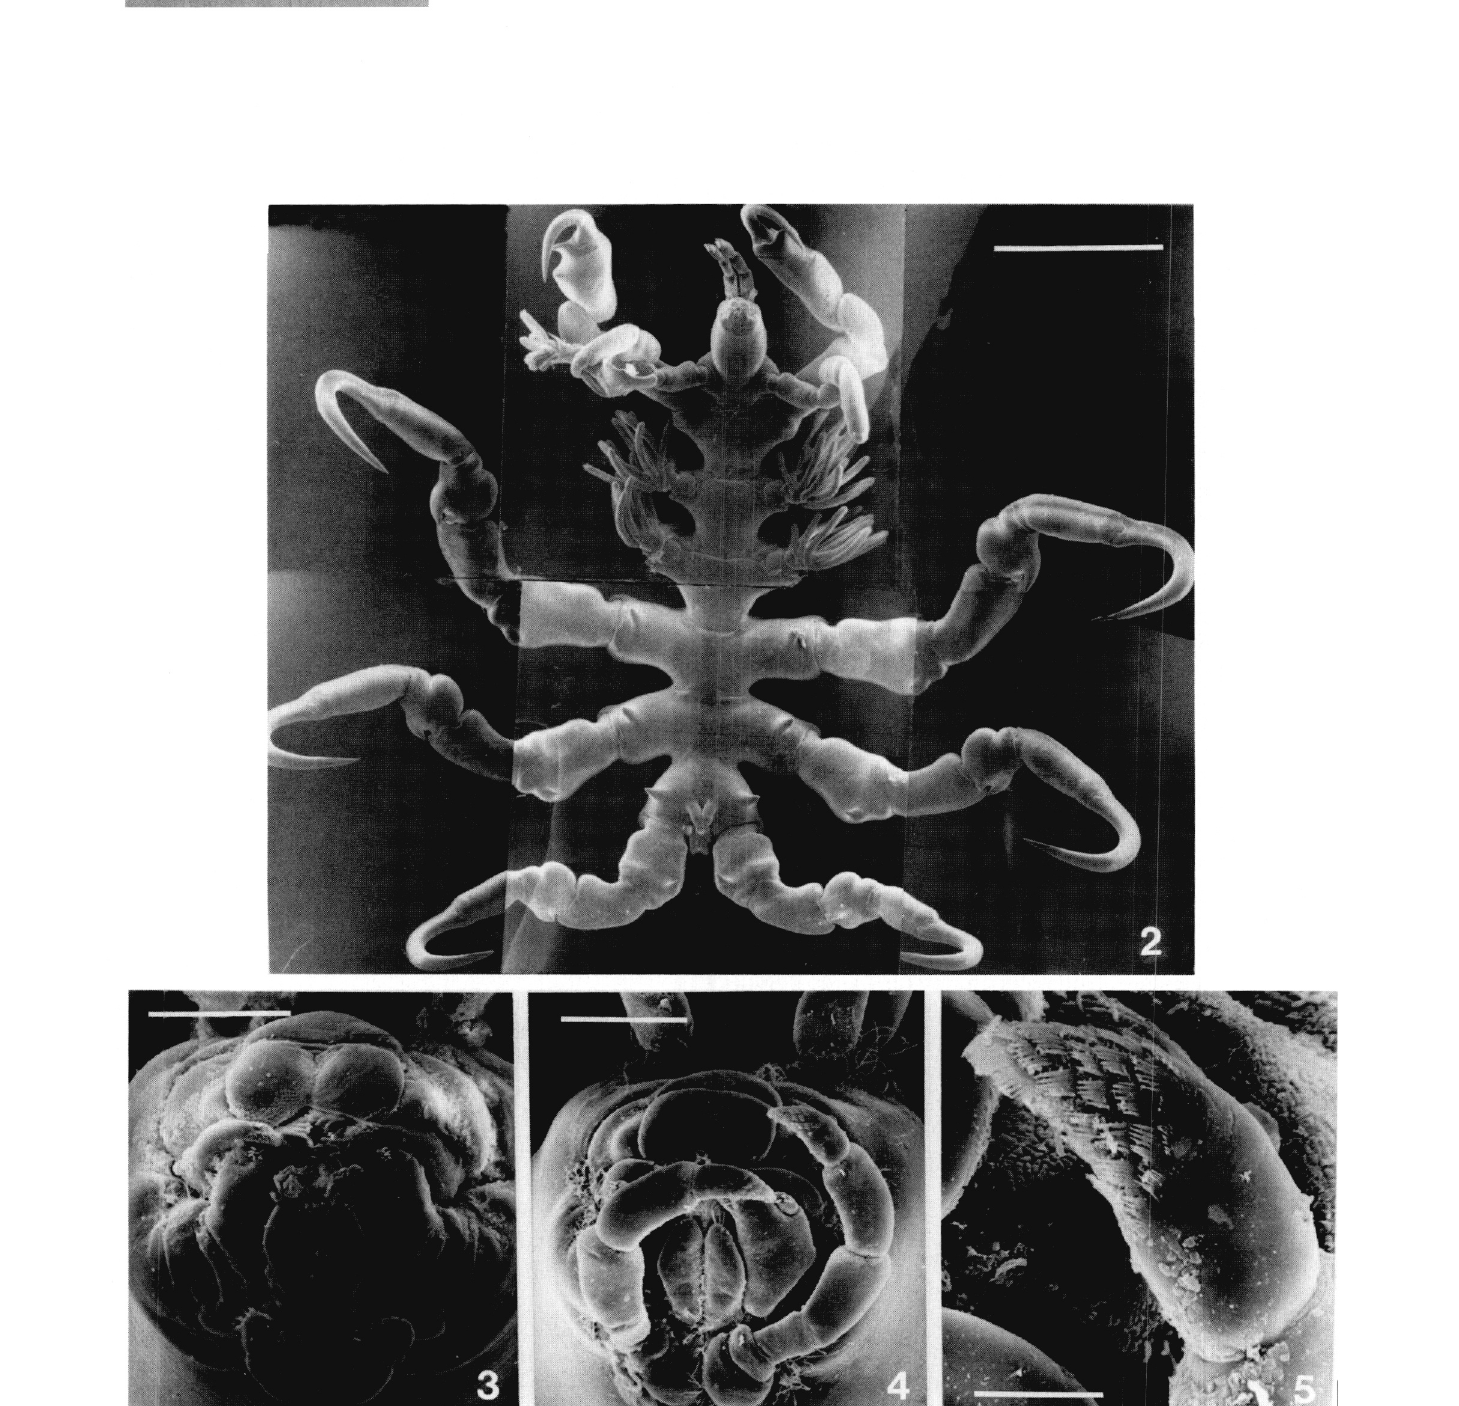
Fig. 2. - Neocyamus physeteris (Pouchet, 1888). Mâle, vue ventrale (échelle : 2 mm). Fig. 3. - Neocyamus physeteris (Pouchet, 1888). Appendices buccaux chez un adulte (échelle : 150 μm). Fig. 4. - Neocyamus physeteris (Pouchet, 1888). Appendices buccaux chez un jeune (échelle : 100 μm). Fig. 5. - Neocyamus physeteris (Pouchet, 1888). Article distal du palpe labial avec ses “peignes" chez un jeune individu (échelle : 20 pm).